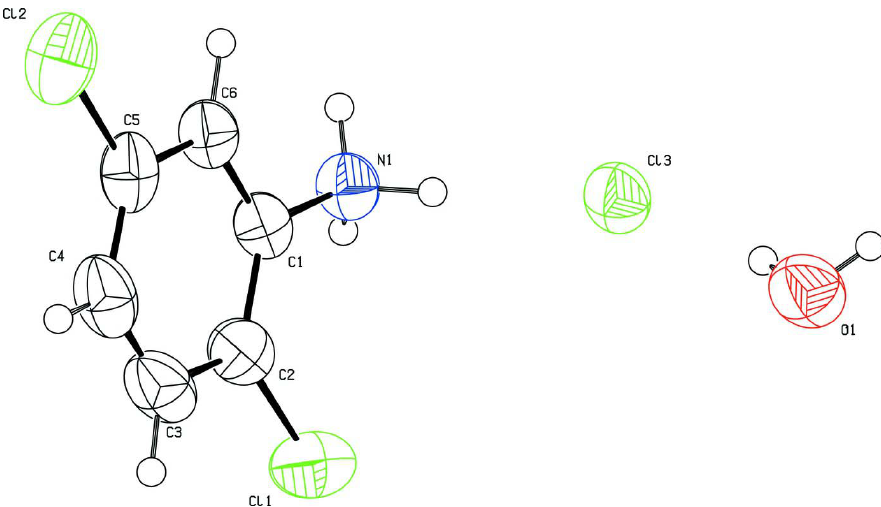
Figure 1 Molecular structure of the title compound, showing the atom labeling scheme. The displacement ellipsoids are drawn at the 50% probability level. The H atoms are represented as small spheres of arbitrary radii.